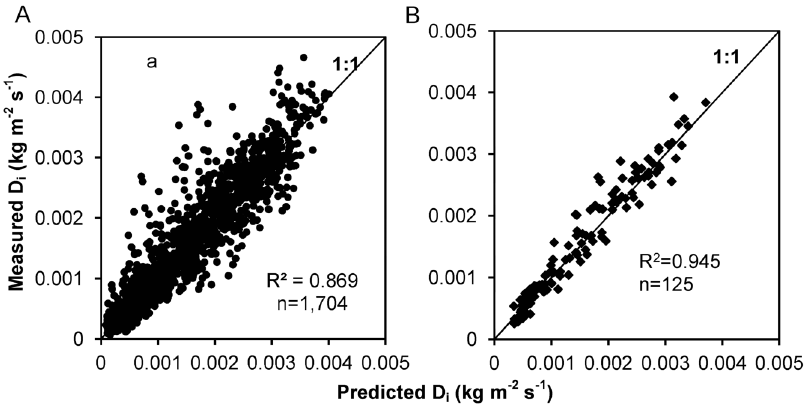
Figure 7. Measured vs. predicted interrill erosion rates. Measured and predicted interrill erosion rates for Eq. (10) for the erosion processes during a rainfall event (A) and the average of each rainfall event